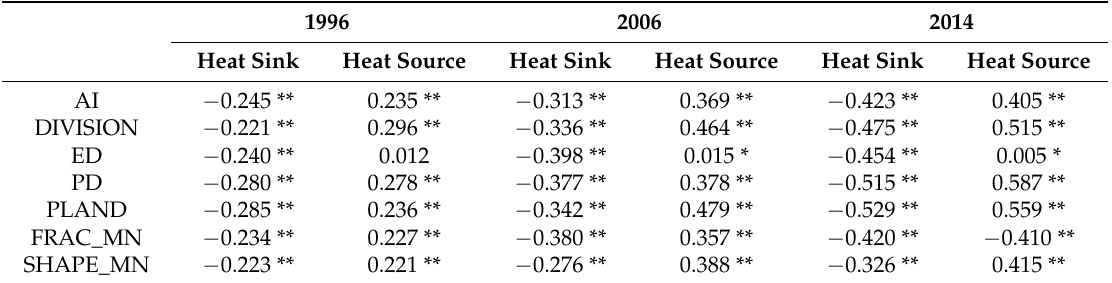
Table 8. Correlation coefficients of class-level landscape features and heat source–heat sink